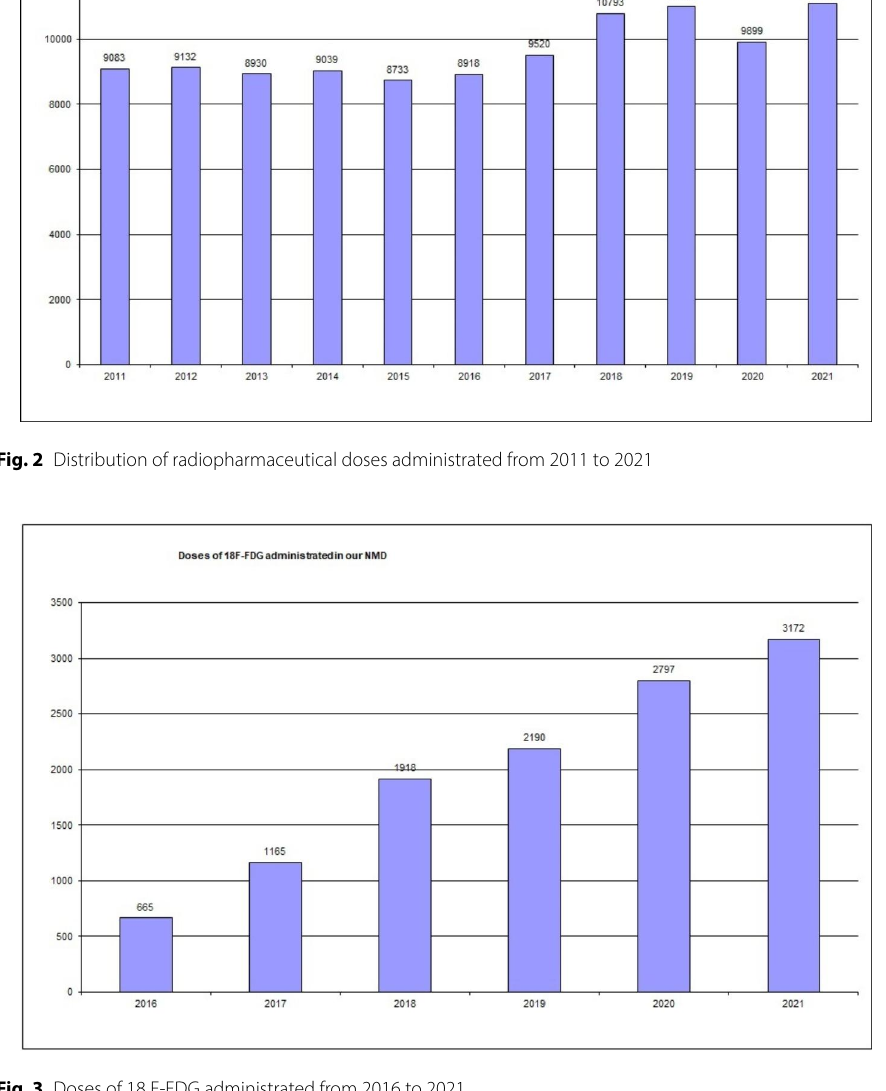
Fig. 3 Doses of 18 F-FDG administrated from 2016 to